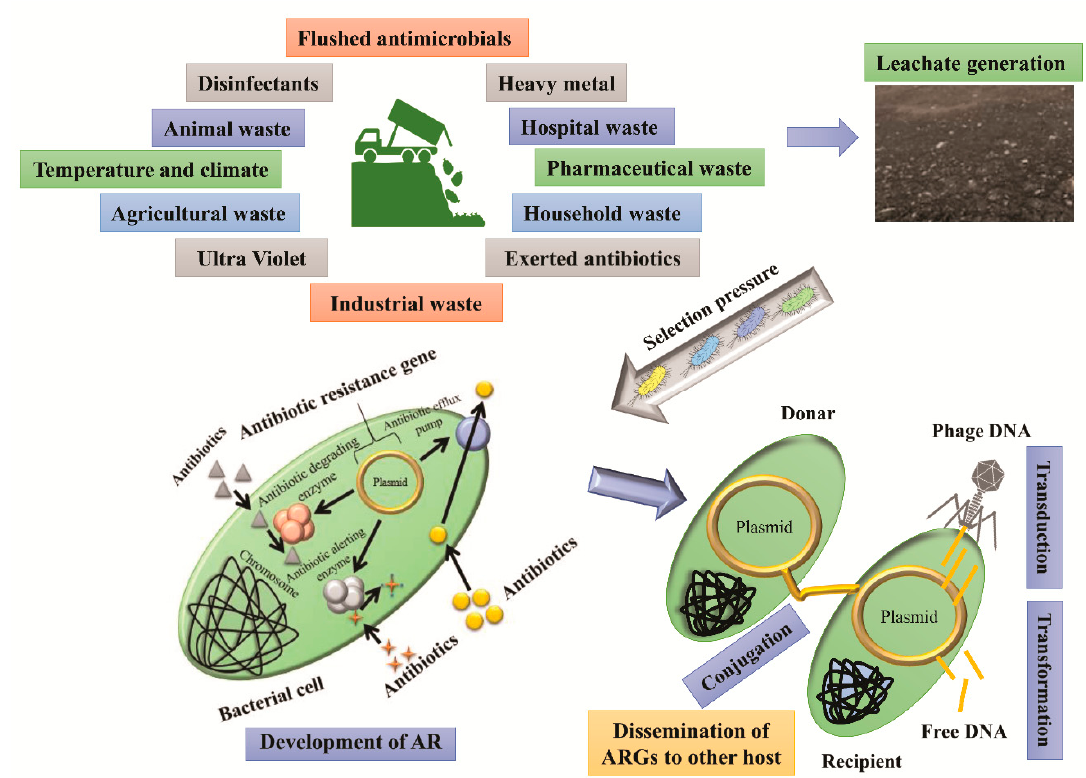
Figure 1. Sources of antibiotics in the landfill system and their mechanisms to adopt an antibiotics resistance (AR) through horizontal gene transfer (HGT). ARGs: antibiotic resistance genes.